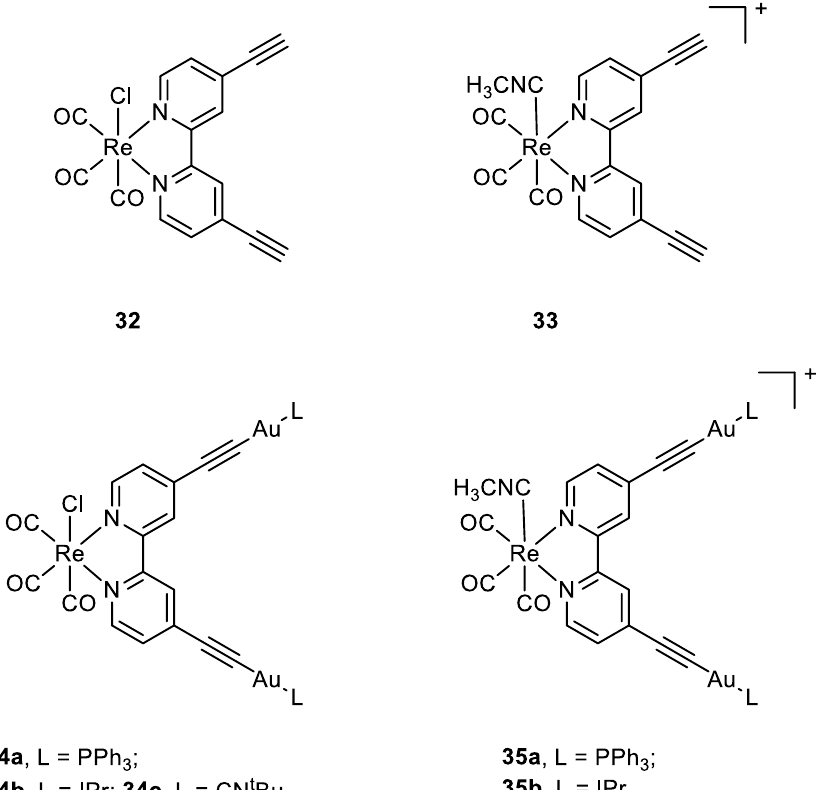
Figure 16. Molecular structure of compounds 32 , 33 , 34a – c , and 35a – b .